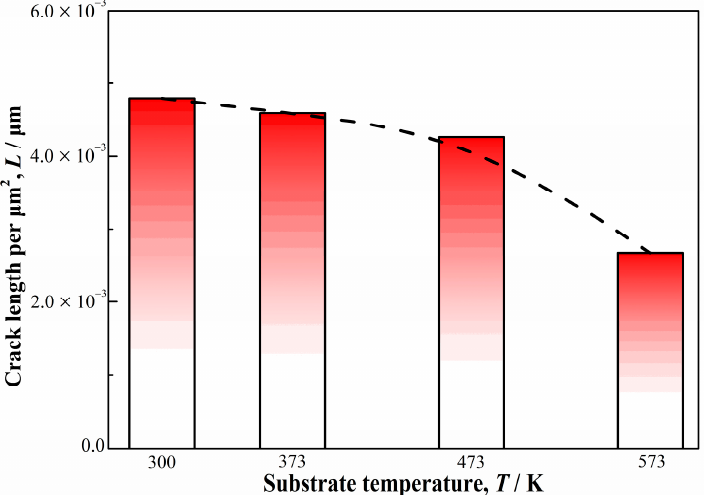
Figure 6. Cross-sectional cracking statistics of Co 55 Ta 10 B 35 amorphous coating at different substrate temperatures. Table 1. Composition analysis of Co 55 Ta 10 B 35 coating in cross section produced at different substrate